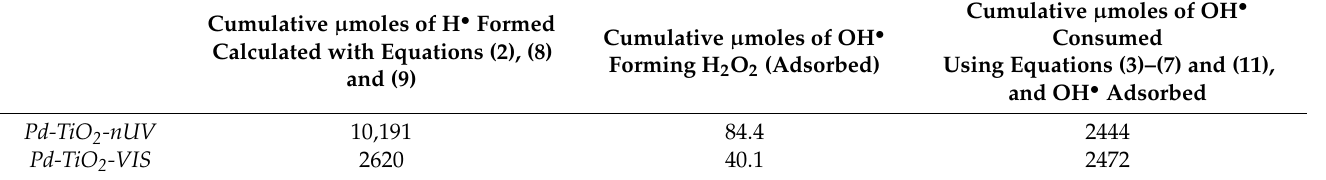
Table 4. Cumulative H • formed/consumed and OH •